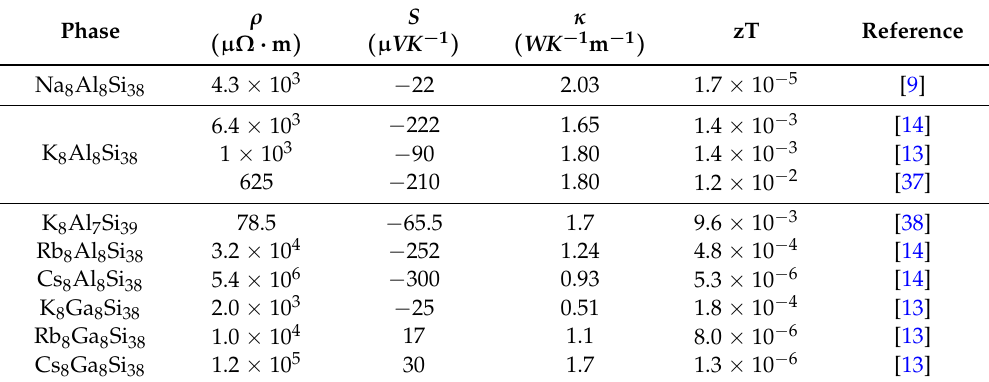
Table 3. Experimental Seebeck coefficient, thermal conductivity, electrical resistivity and figure of merit zT for A 8 E 8 Si 38 and related clathrates estimated at 300